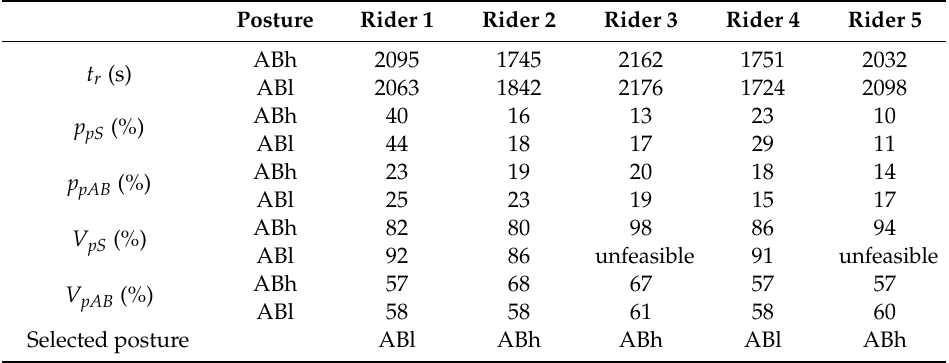
Table 7. Race time, and pressure and vibrations threshold percentages computed for a zero-wind, zero-grade race